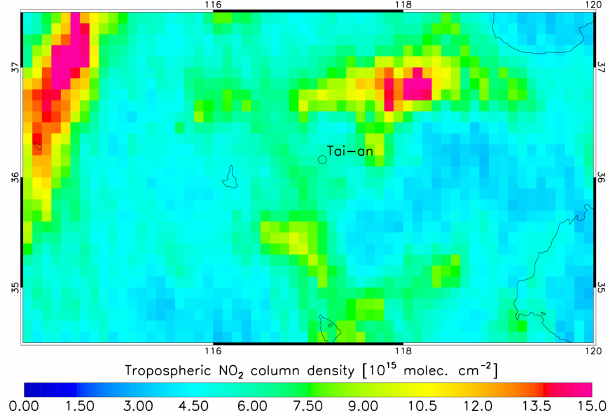
Figure 11. Campaign mean (30 May–30 June 2006) of the QA4ECV tropospheric NO 2 column distribution over eastern China for clear-sky situations (cloud radiance fraction <0.5). The black circle indicates the location of Tai’an, where Chiba University operated the MAX-DOAS instrument. One cell corresponds to 0.1 ◦ × 0.1 ◦ . On average there are 15 satellite pixels per cell used to calculate the campaign